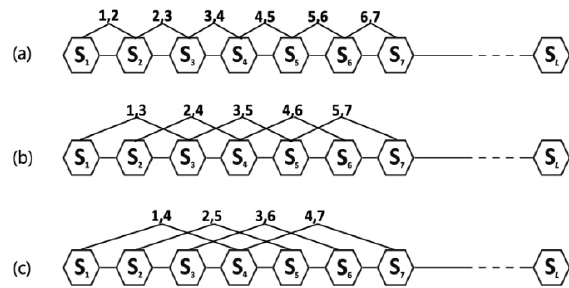
Figure 1. A schematic diagram to show: ( a ) the first-tier; ( b ) the second tier; and ( c ) the third-tier sequence order correlation mode along a sequence. Where the regular hexagon is used to show that each element of the sequence corresponds to one of the six amino acid groups.